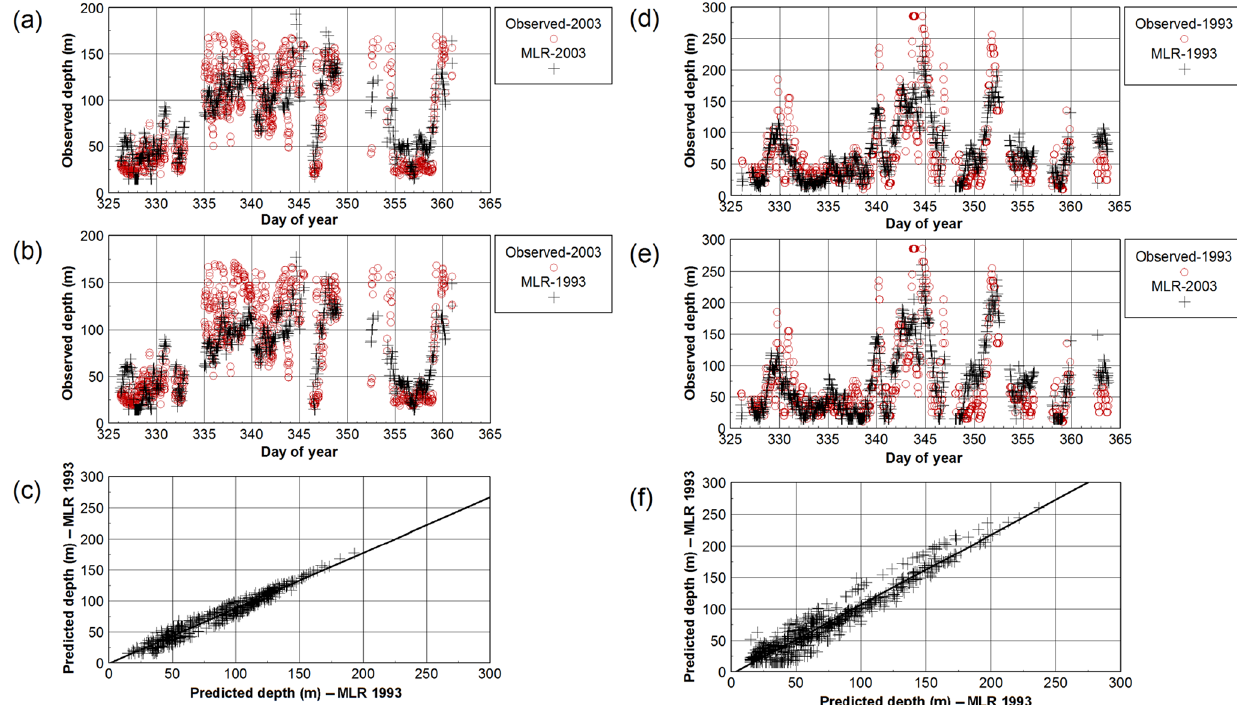
Figure A1. (a) Comparison of 2003 observed BLD with that predicted by the 2003 MLR equation with r 2 = 0 . 71. (b) Comparison of 2003 observed BLD with that predicted by the 1993 MLR equation with r 2 = 0 . 67. (c) Least-squares fit for MLR1993 vs. MLR 2003 with r 2 = 0 . 96. (d) Comparison of 1993 observed BLD with that predicted by the 1993 MLR equation with r 2 = 0 . 65. (e) Comparison of 1993 observed BLD with that predicted by the 2003 MLR equation with r 2 = 0 . 61. (f) Least-squares fit for MLR2003 vs. MLR 1993 with r 2 = 0 . 93.